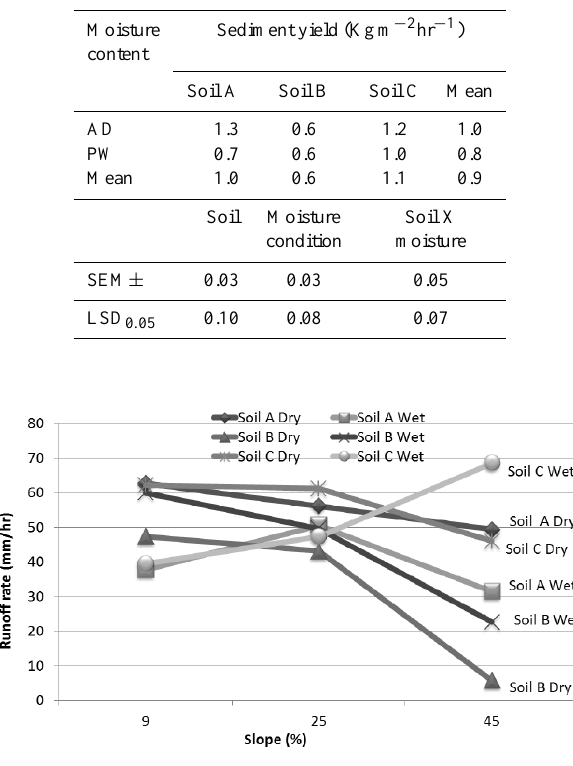
Table 5. Effect of the different combinations of soil type and mois- ture content on runoff rate.